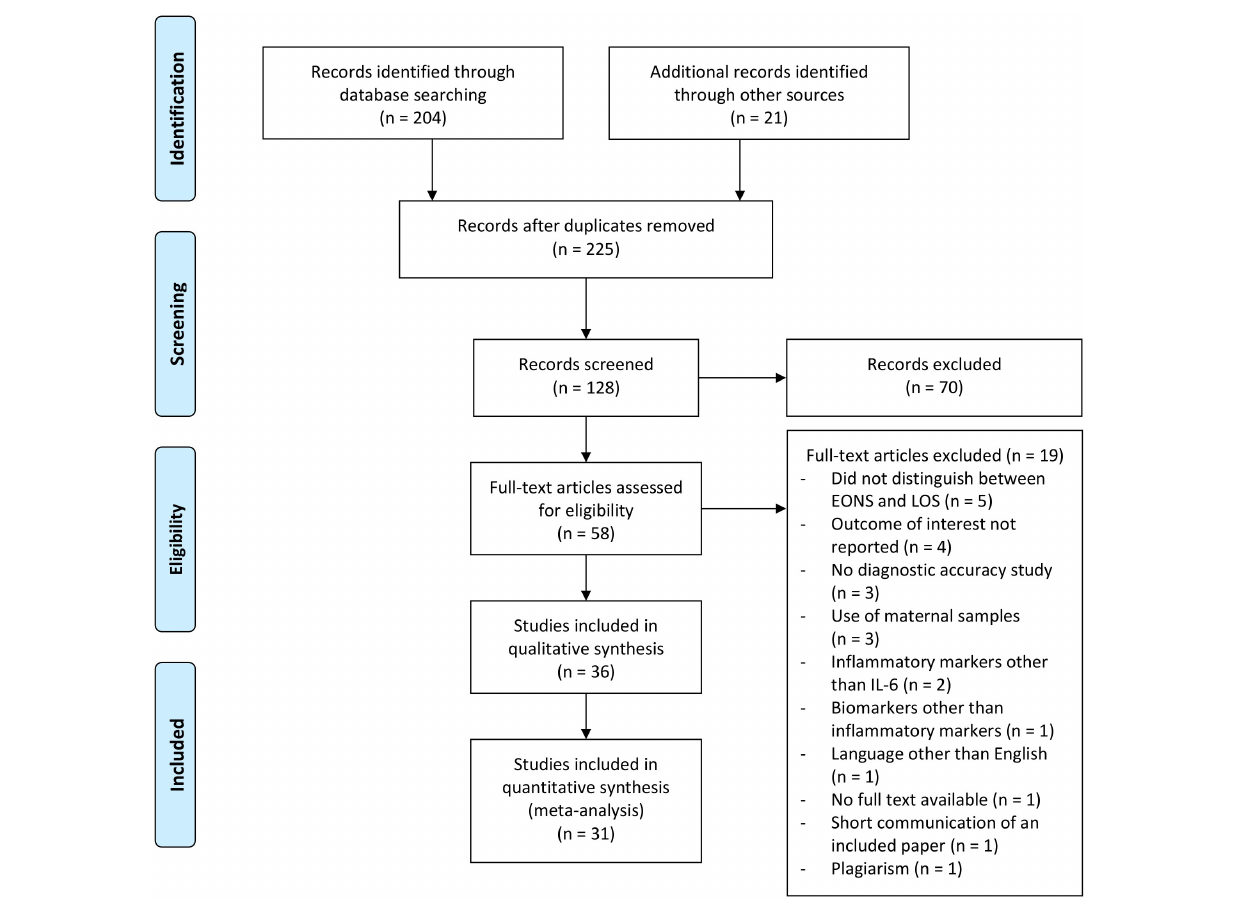
FIGURE 1 | Flowchart of the study selection process for diagnostic accuracy of interleukin-6 in early onset neonatal sepsis between 1990 and 2020.